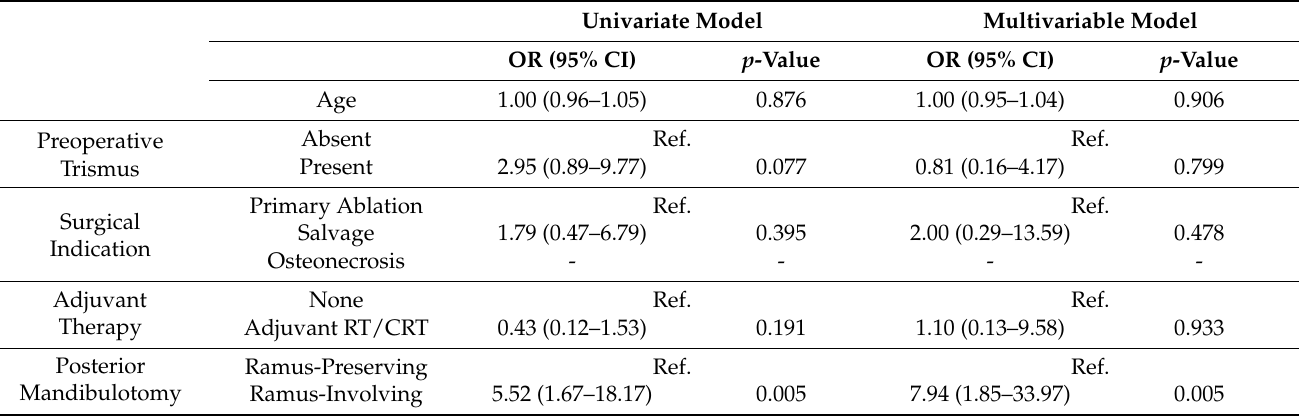
Table 3. Univariate and multivariable logistic regressions for the presence of persistent late postoper- ative trismus (>6 months